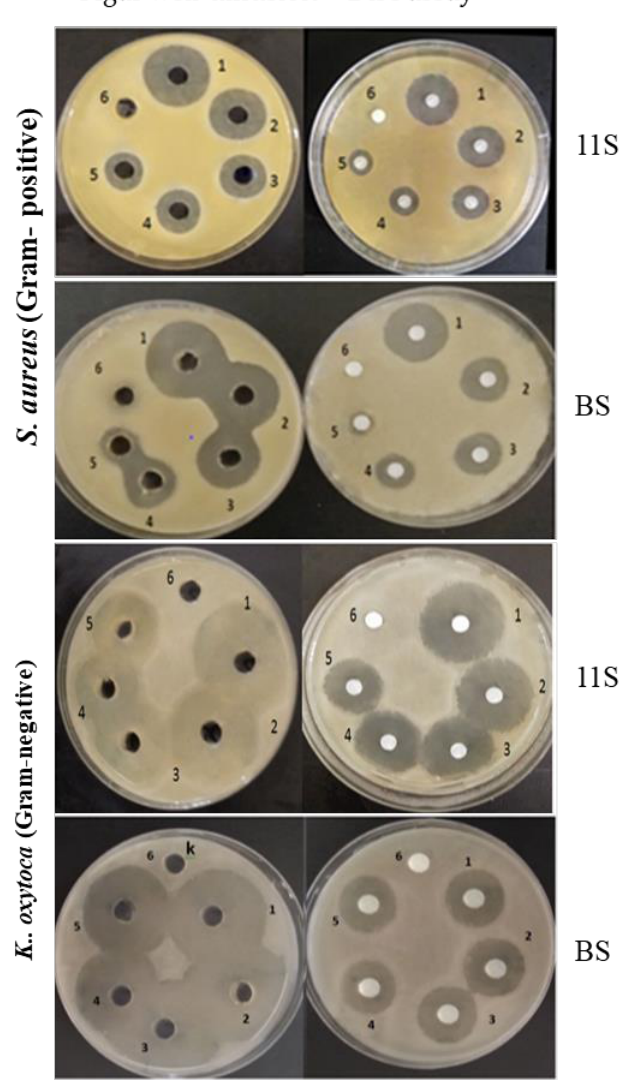
Figure 6. Antibacterial sensitivity test of 11S globulin and BS against Gram-positive ( S. aureus ) and Gram-negative bacteria ( K. oxytoca ). The numbers (1–10) correspond to 8, 4, 2, 1, 0.5, 0.3, 0.1, 0.05, 0.025, and 0.0125 µg/mL, respectively. Table 1. Bacterial inhibitory actions of graded concentrations of lupine 11S globulin using agar well diffusion and disk assay techniques (A) and statistical significance (B).